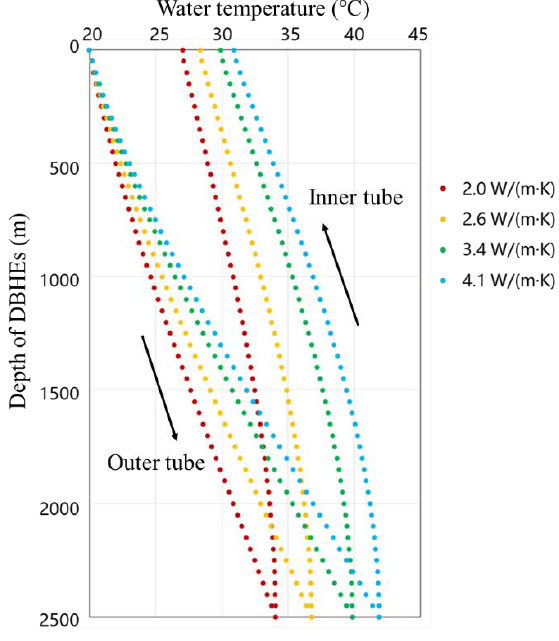
Figure 13. The water temperature distribution under different ground thermal conductivity.